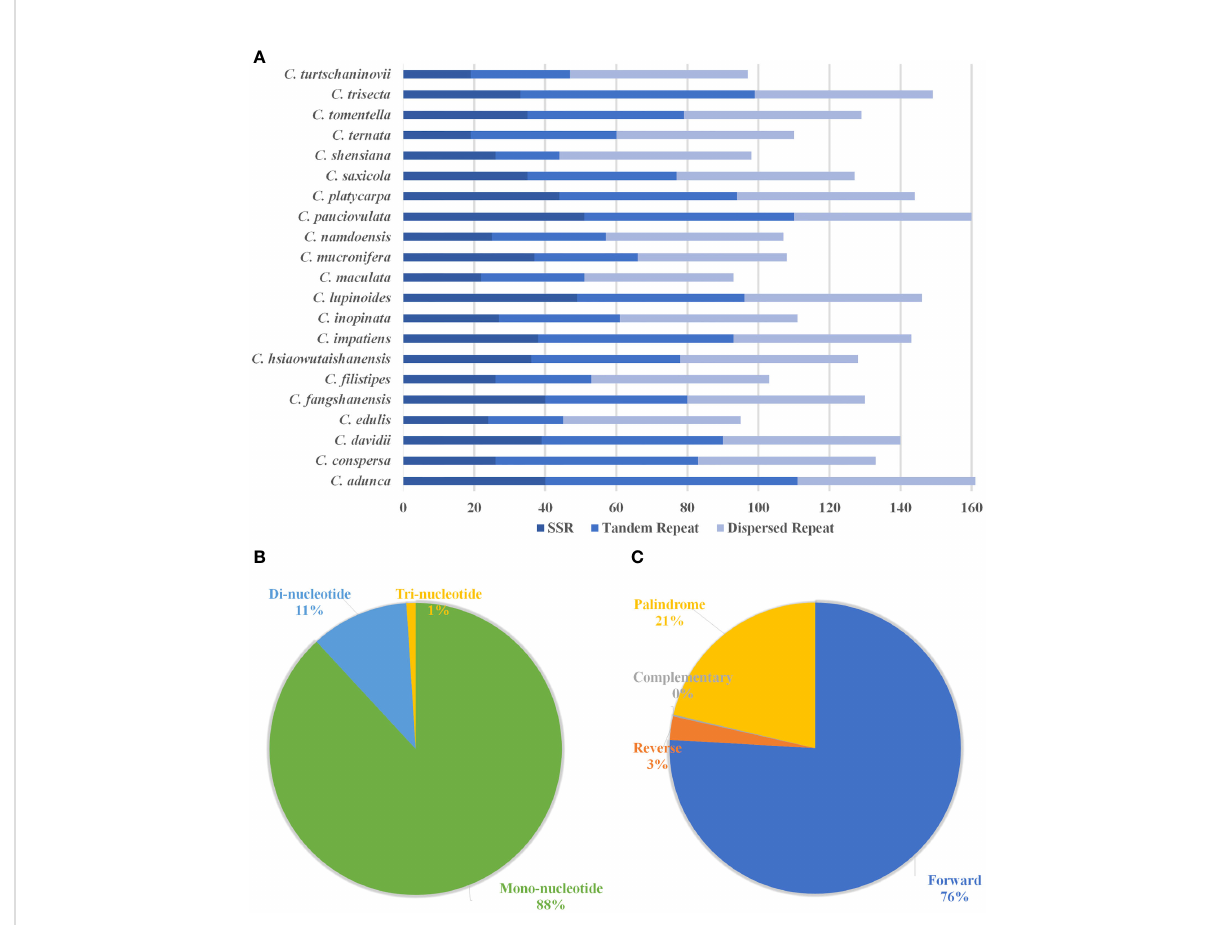
FIGURE 4 Histogram shows the number of repeats in 21 Corydalis chloroplast genomes. (A) The distribution of simple sequence repeats (SSRs), tandem repeats, and dispersed repeats in the 21 Corydalis plastomes. (B) Proportion of different SSR repeat types in the 21 plastomes of Corydalis . (C) The number of different types of dispersed repeats in the 21 Corydalis